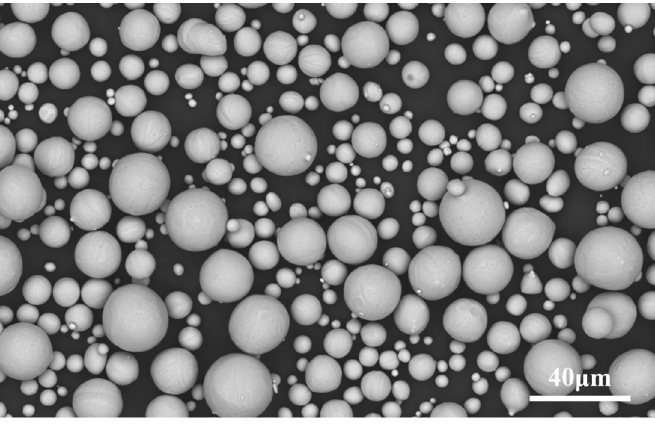
Figure 1. Morphology of Ti6Al4V powder under SEM. Table 1. Chemical compositions of Ti6Al4V powder(wt%).